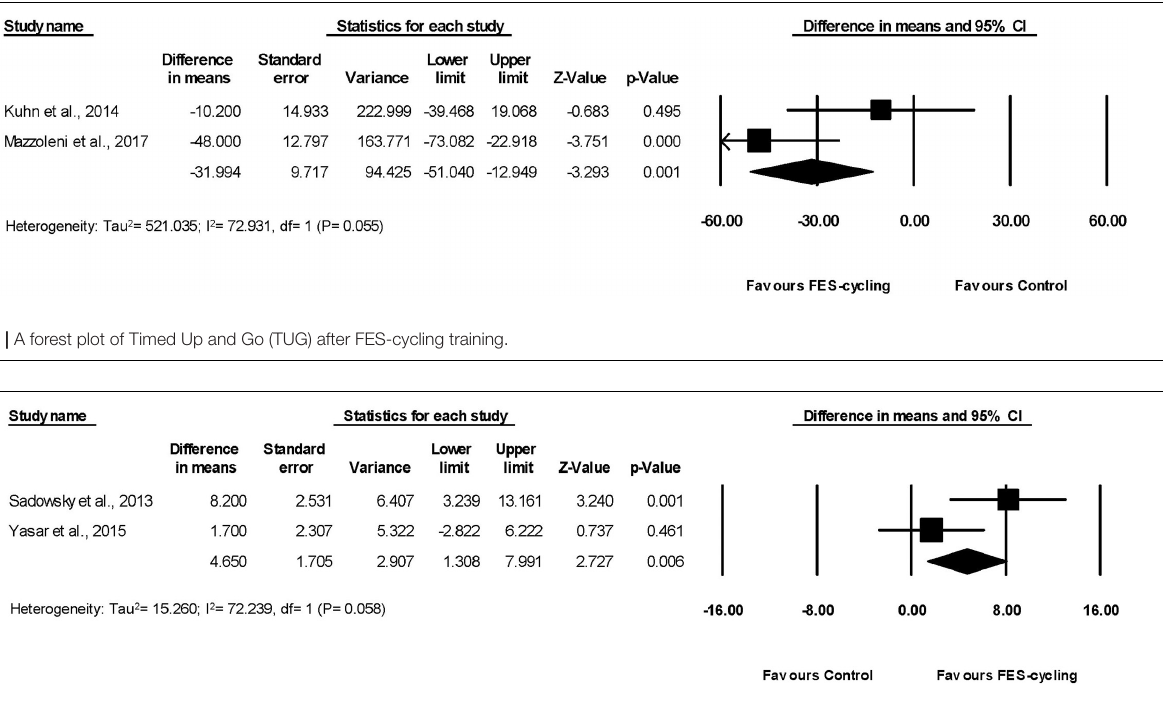
FIGURE 8 | A forest plot of lower limbs muscle strength (LEMS) after FES-cycling training.